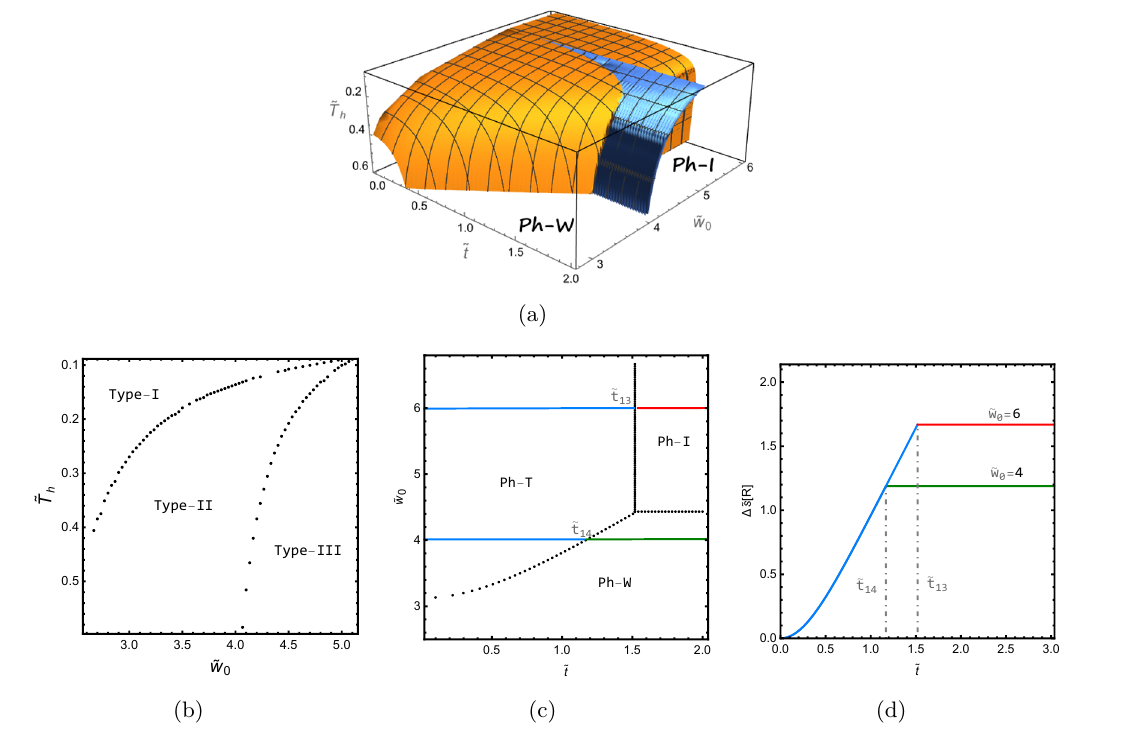
˜ Figure 7 . (a): the phase diagram in { ˜ w 0 , ˜ t, T h } . The region inside the orange surface is in Ph- T . The region outside the orange surface is divided by the blue surface into Ph- W and Ph- I . (b): the different types of evolution, with ˜ w ( ˜ T ) and ˜ w ( ˜ T ) being two critical distances. (c): for c 1 h c 2 h ˜ T h = 6 / 8 π , the projected phase diagram in { ˜ w 0 , ˜ t } . (d): two Page curves for radiation R , with Page time ˜ t = ˜ t and ˜ t = ˜ t respectively. Segments in blue, green and red, represent the combined 14 13 system is in Ph- T , W and I ,